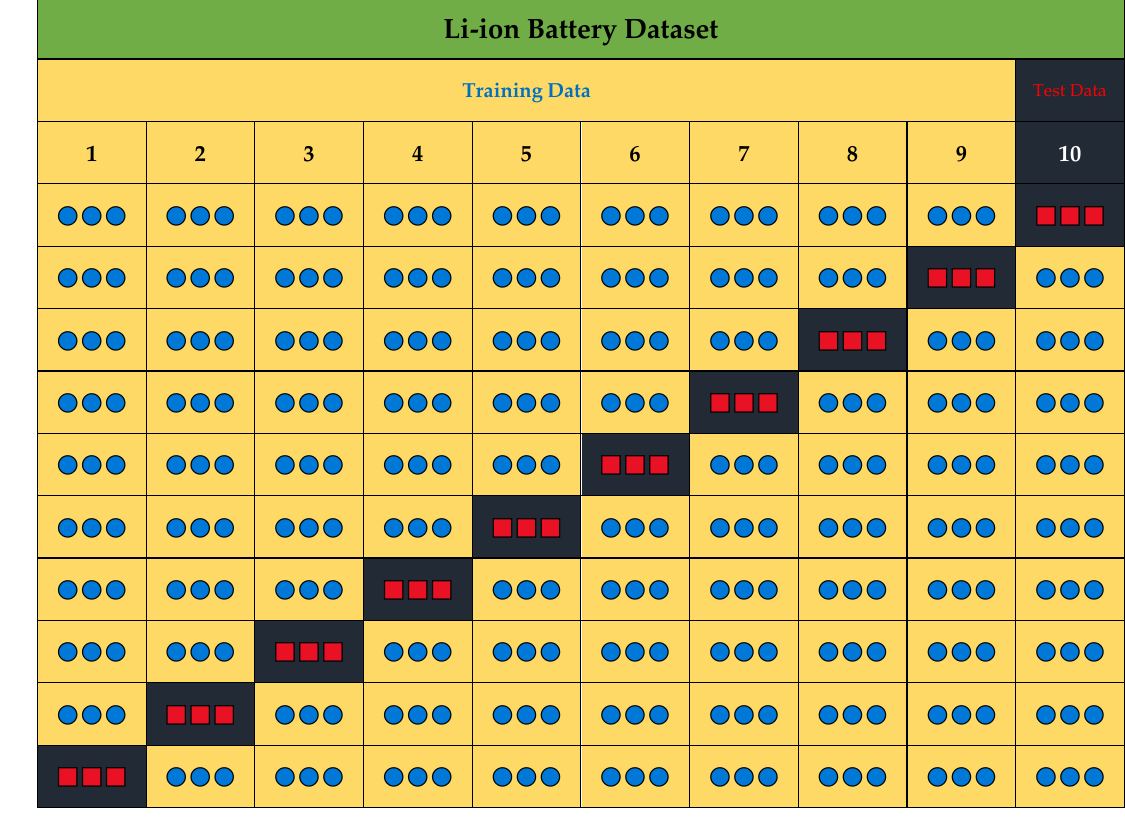
Figure 8. Ten-fold procedure applied to Li-ion battery